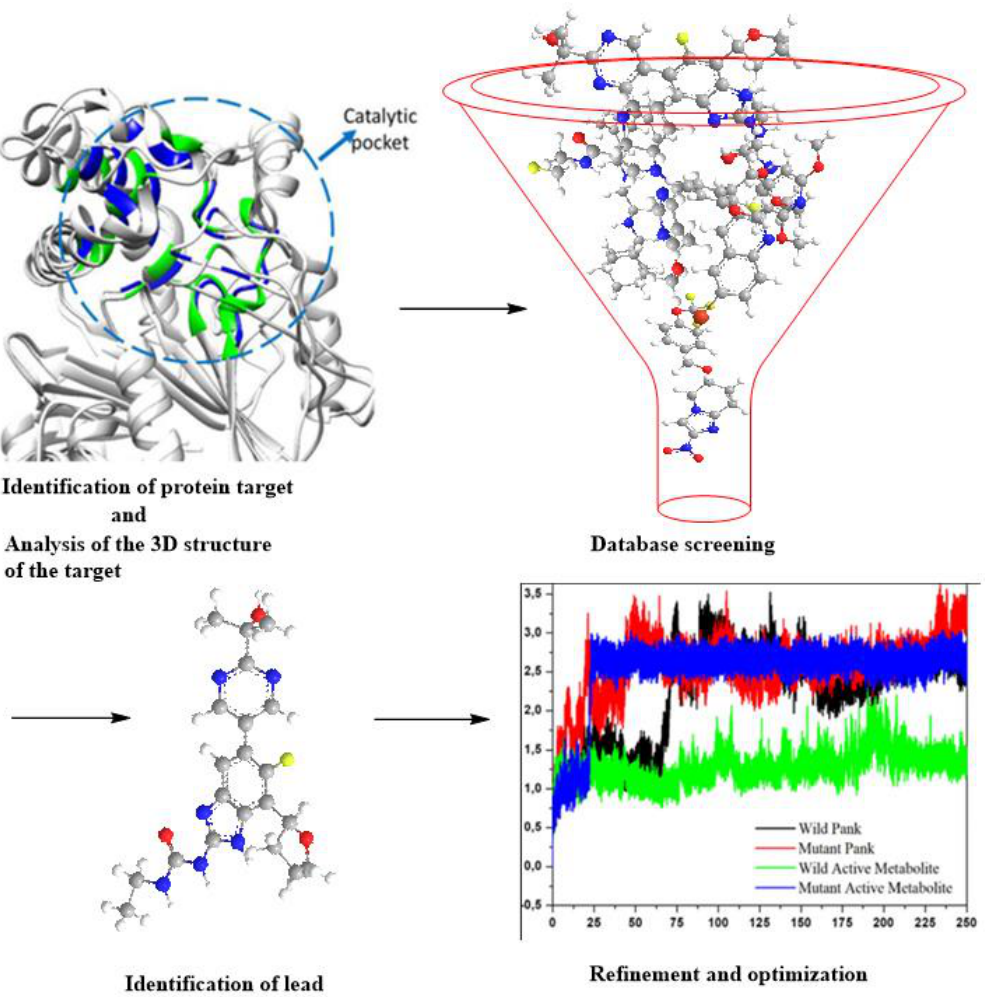
Figure 8. An illustration of the SBDD